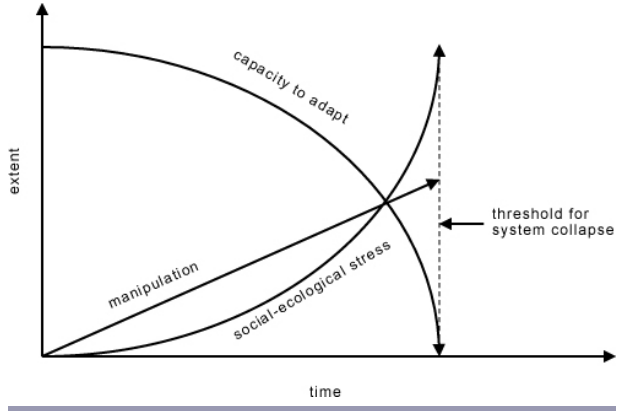
Fig. 1. Relationship among manipulation, adaptive capacity, and social–ecological